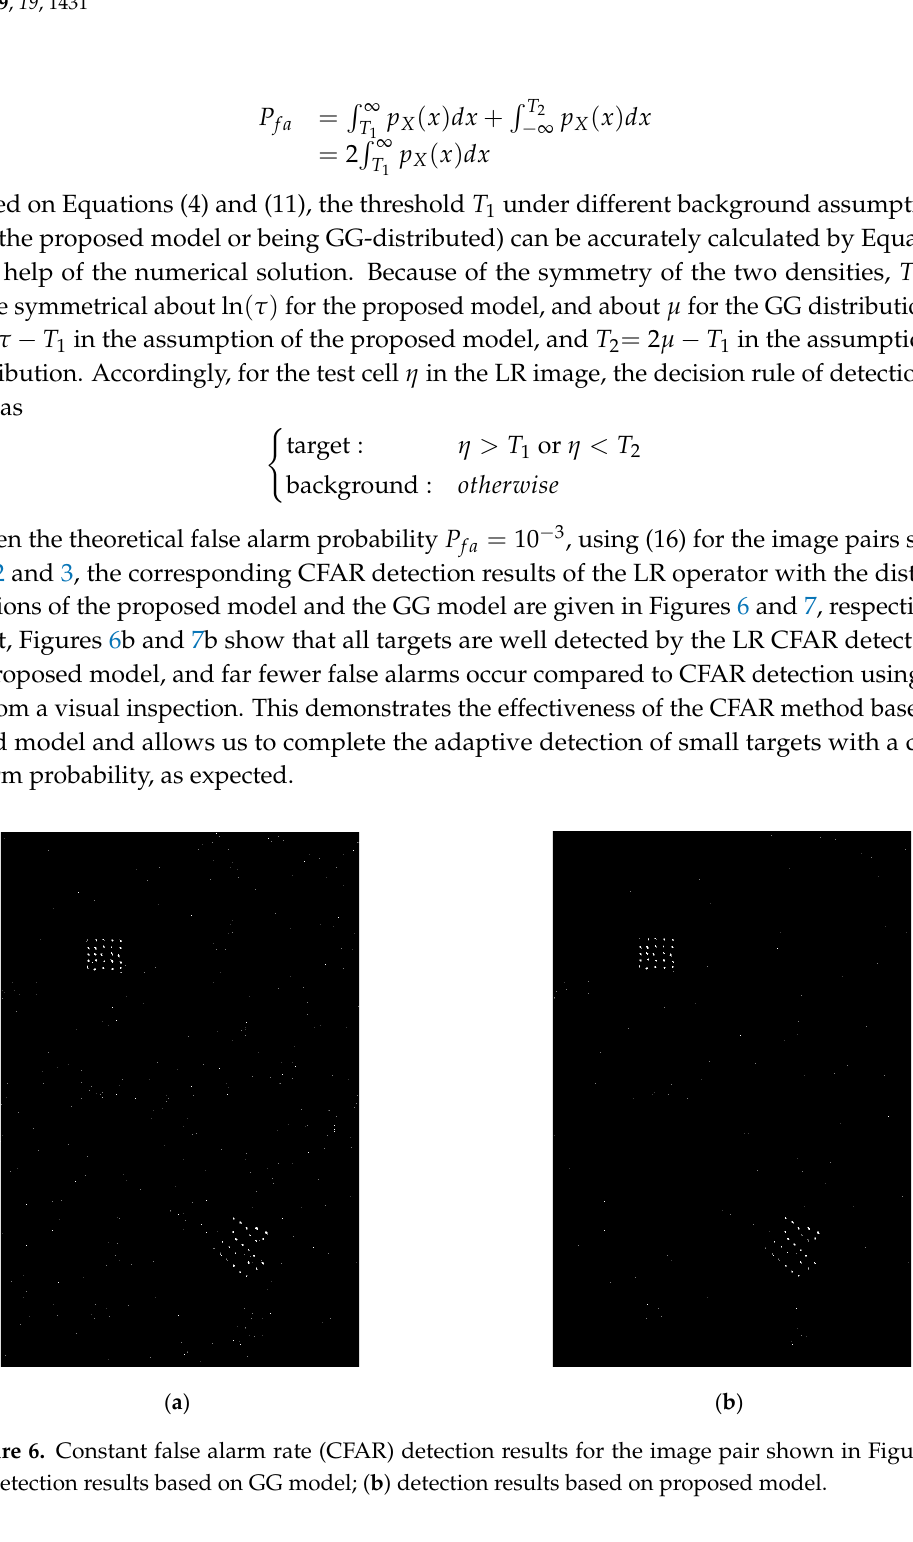
( b ) Figure7. CFAR detection results for the image pair shown in Figure3: ( a ) detection results based on GG model; ( b ) detection results based on proposed model. First, Figures 6(b) and 7(b) show that all targets are well detected by the LR CFAR detector based on the proposed model, and far fewer false alarms occur compared to CFAR detection using the GG model from a visual inspection. This demonstrates the effectiveness of the CFAR method based on the proposed model and allows us to complete the adaptive detection of small targets with a desirable false alarm probability, as expected. Second, if detections are found to exist within a radius of 10 m from a ground truth position, the target is declared to be found, and can be counted. All other detected changes that are not considered to be related to a target are regarded as false alarms. A whole performance comparison between the